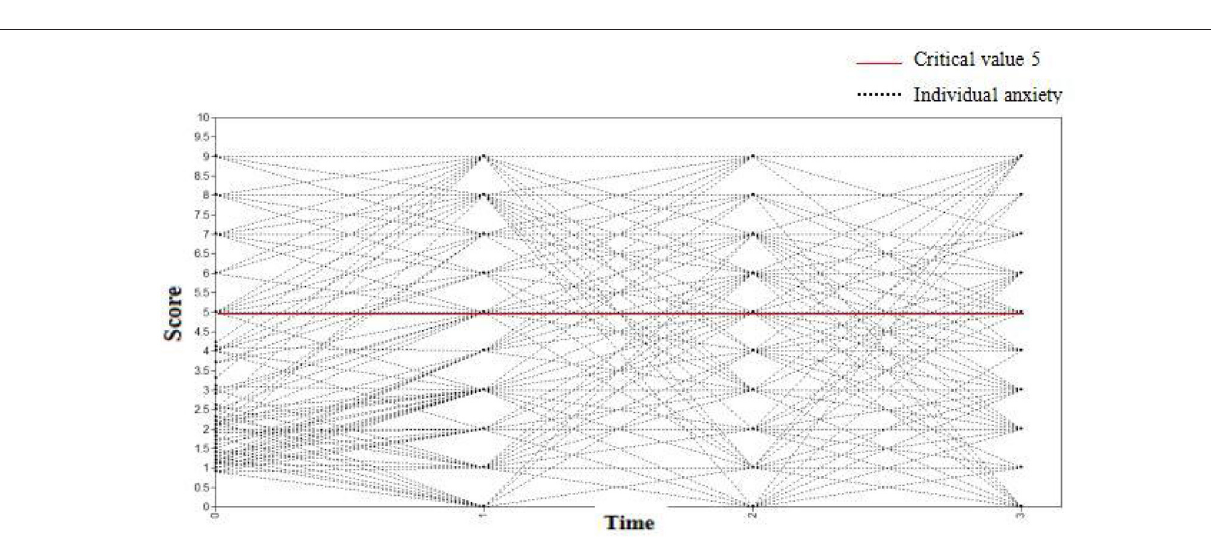
of medical staff at each observation point indicated that they were